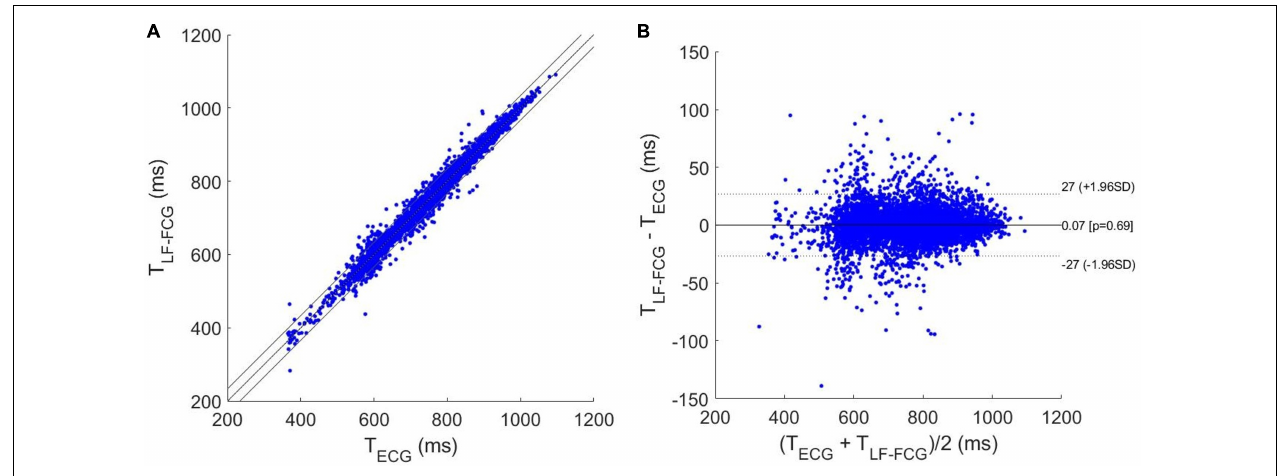
FIGURE 8 | Statistical analyses on inter-beat intervals estimated from ECG and LF-FCG: (A) results of regression and correlation analyses; (B) results of Bland-Altman analysis.